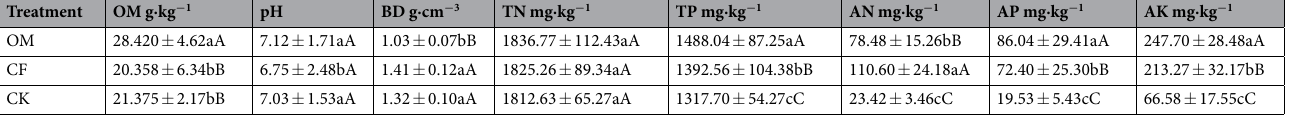
Table 6. Soil fertility parameters under the different treatments after a 4-year experiment. Note: OM = organic matter; BD = bulk density; TN = total nitrogen; TP = total phosphorus; AN = alkali-hydrolysable nitrogen; AP = available phosphorus; and AK = available potassium. The different lowercase and uppercase letters in the same column indicate a significant difference at the 0.05 and 0.01 levels,